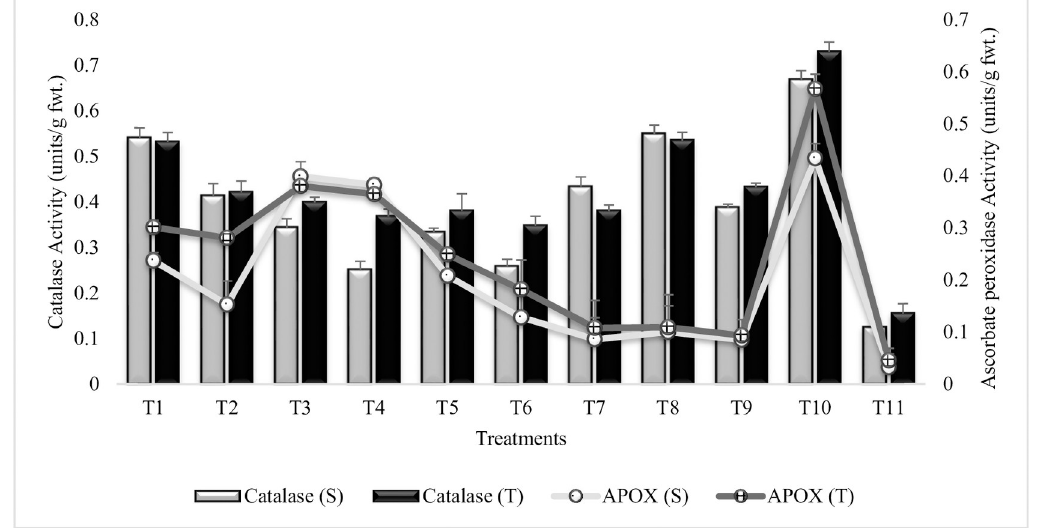
Fig 6. Catalase and ascorbate peroxidase activities of chickpea grown in sandy soil. Data are means of four replicates along with standard error bars (S-Sensitive Variety; T-Tolerant Variety).